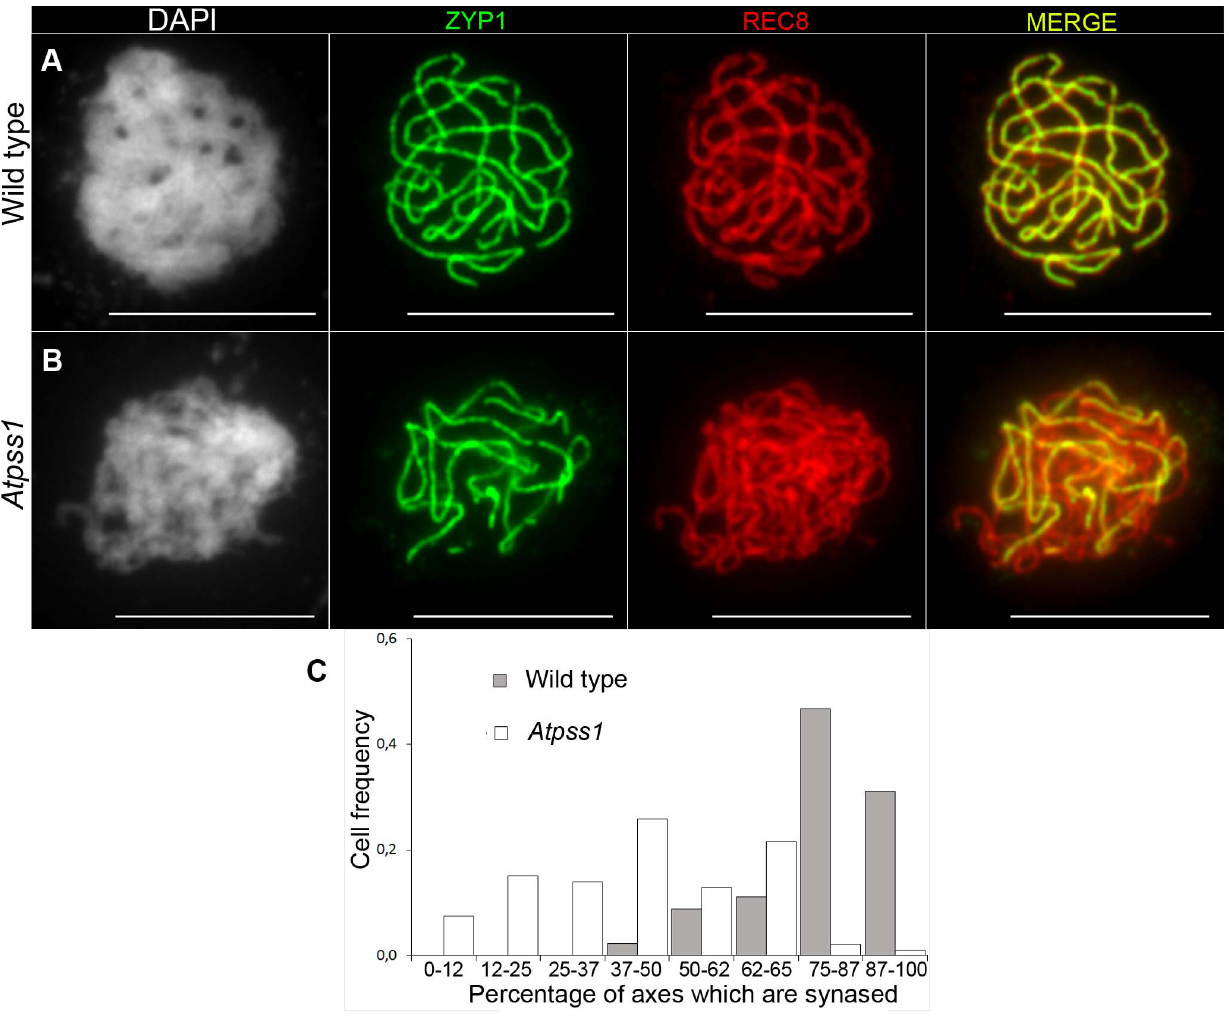
Figure 3. Co-immunolocalization of REC8 and ZYP1 at pachytene. Floral buds of the correct size or bigger for the late pachytene/diplotene stage in wild type were used to make spreads according to Armstrong et al. [42]. Scale bar=10 m m. (A) Wild type. (B) Atpss1-1 . (C) Histogram of cells according to their proportion of synapsed axes. The proportion of synapsed axes in each cell was estimated by measuring the frequency of [red and green] pixels among the total number of [red] pixels. For example on figure 3B, 51% of the ASY1 red signal (axes) colocalize with the ZYP1 green (synapsis) signal.